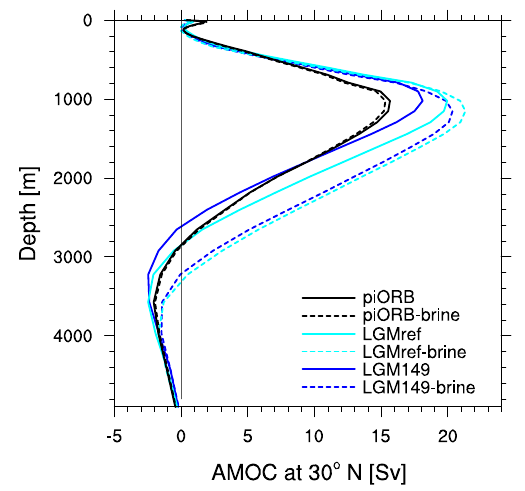
Figure 14. Profile of the AMOC at 30 ◦ N. Experiments with re- duced brine release are indicated by dashed